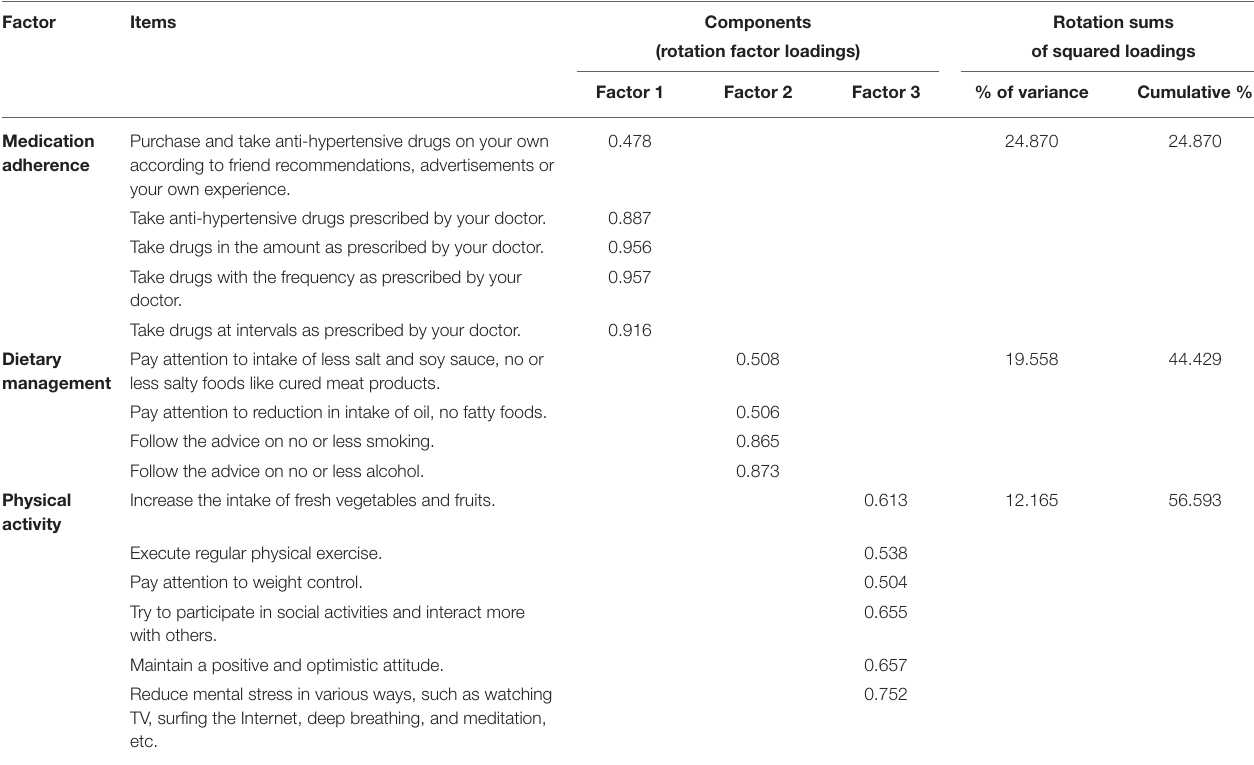
TABLE 2 | Factor analysis with factor loadings for